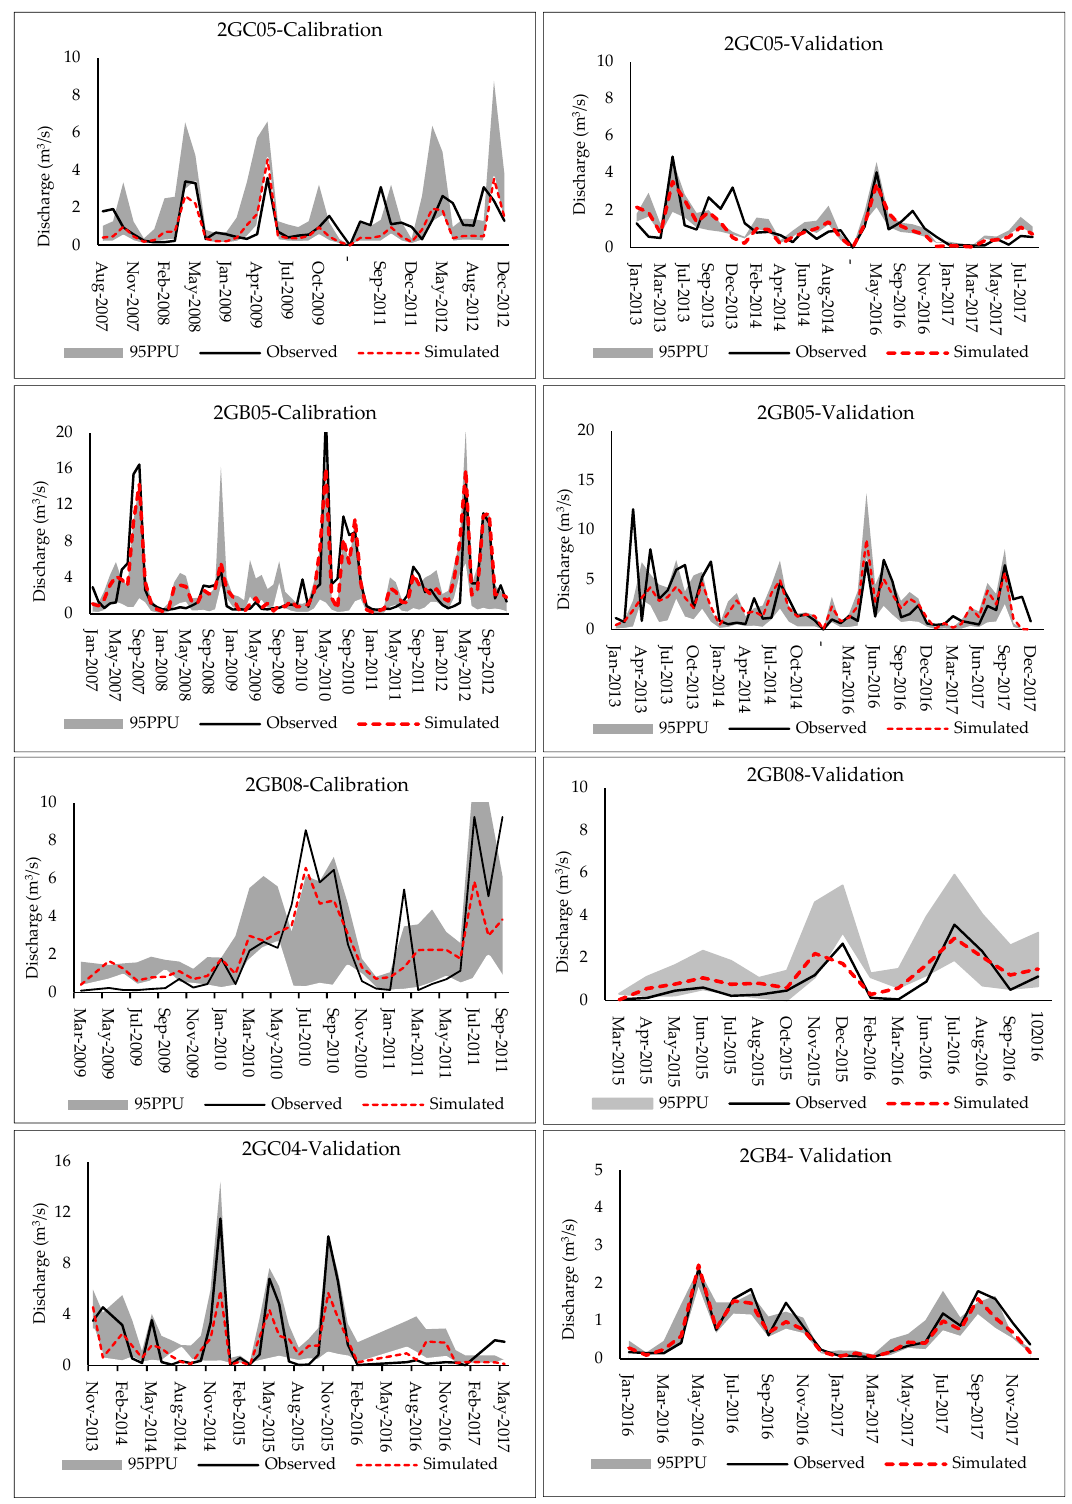
Figure 3. Monthly discharge calibration and validation for different gauge stations.